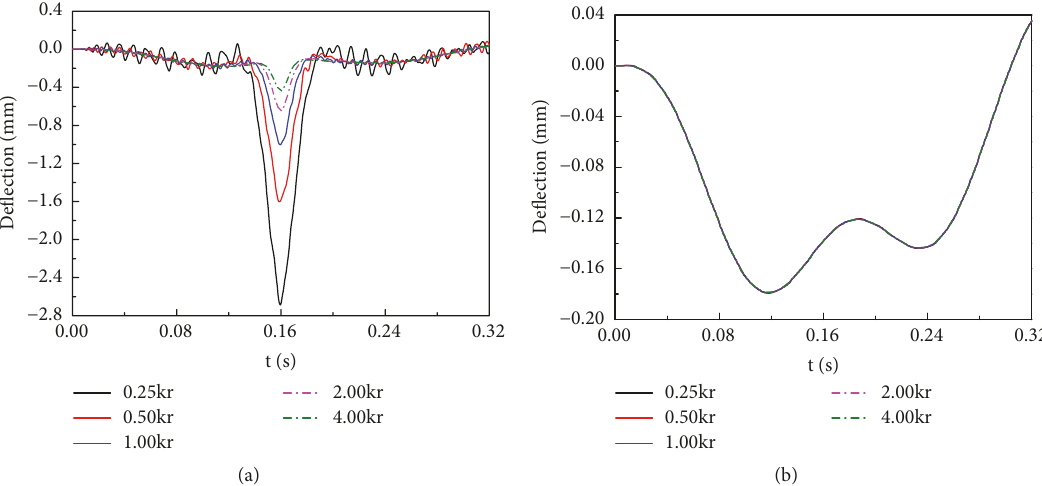
Figure 12: Comparison diagram of mid-span deflection time-history for the double simply supported rail-bridge system under different interlayer stiffness: (a) first beam; (b) second beam.